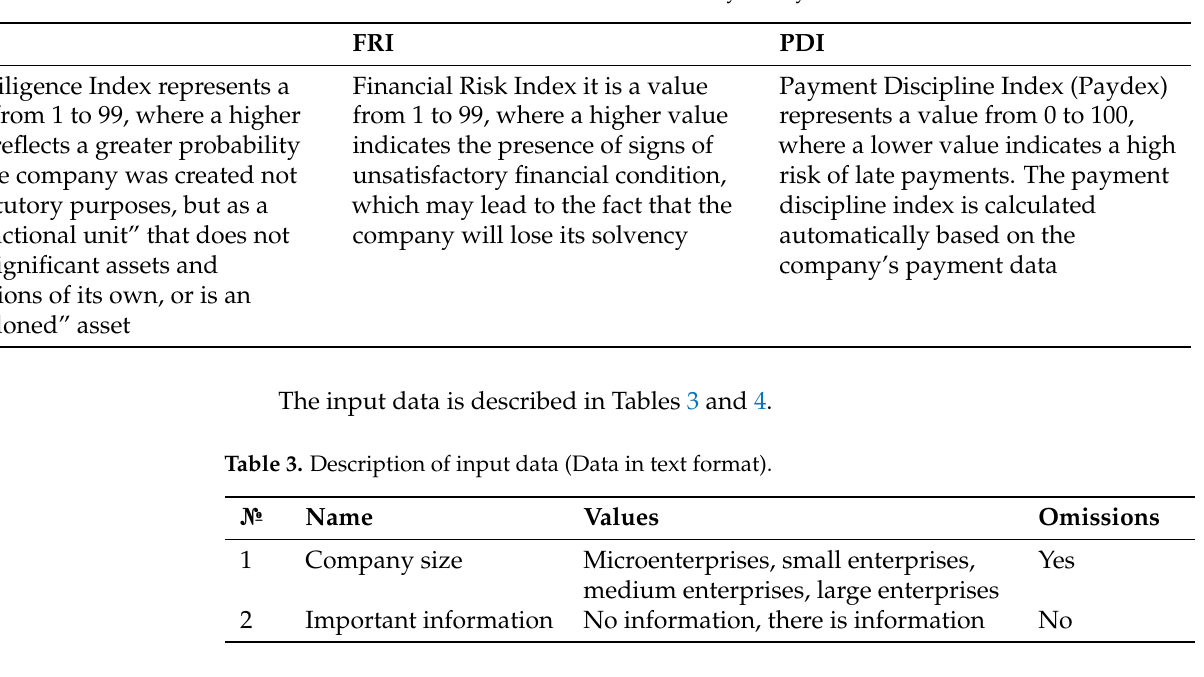
Table 2. Risks in the SPARK information and analytical system.